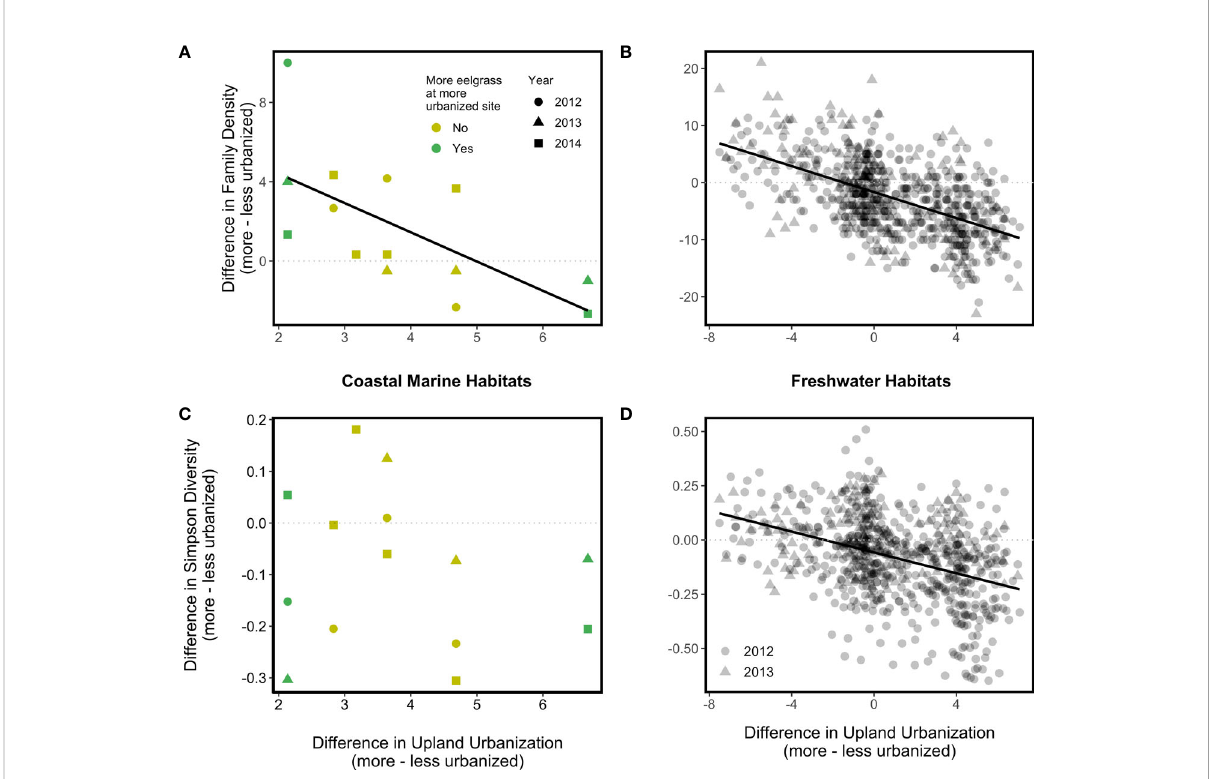
FIGURE 2 Associations between the upland urbanization difference and disparity between more and less urbanized watersheds in two measures of invertebrate diversity (top, Family Density; bottom, Simpson Diversity) in coastal marine (A, C) and freshwater (B, D) habitats. Solid regression lines indicate statistically signi fi cant associations; dotted lines serve as a reference representing zero difference in the diversity indices between more and less urbanized